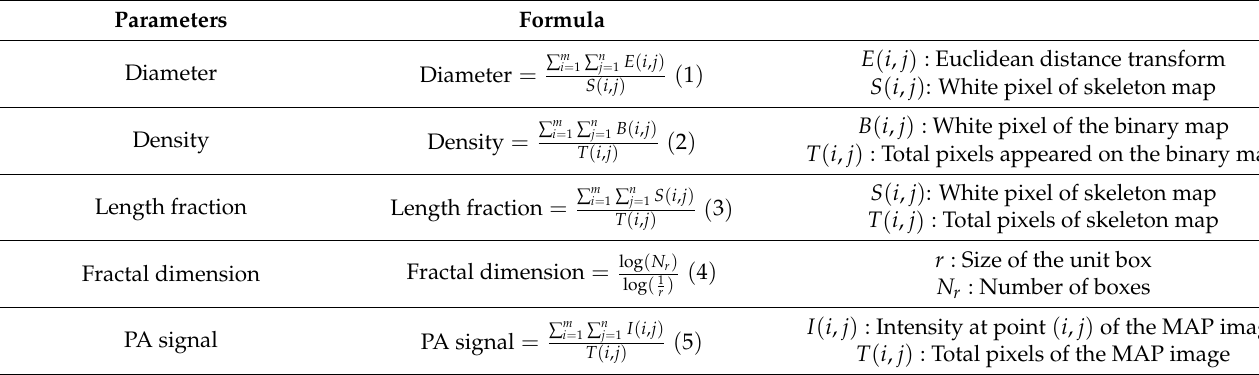
Figure 2. Flow chart of the quantitative OR-PAM image evaluation process. Table 1. The formulas of quantitative parameters.